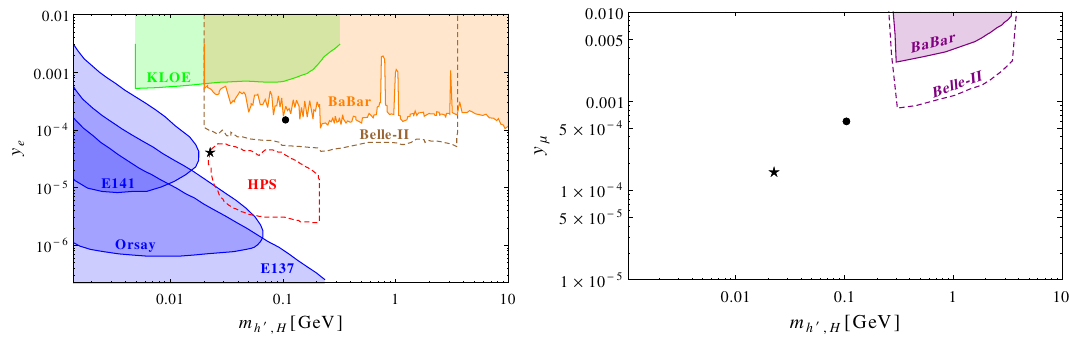
Figure 9 . Relevant constraints to our scenario, where the color shaded regions with solid boundary indicate to the excluded regions by current experiments, and the unshaded regions with dashed boundaries are future projections (see text for